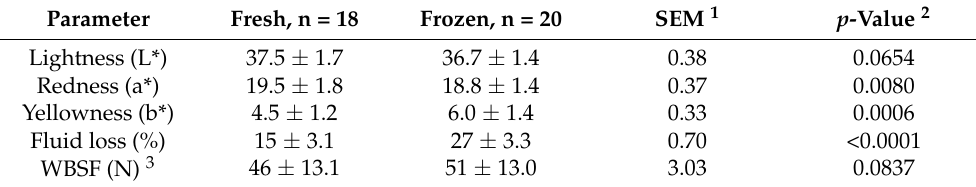
Table 1. Colour parameter values, cooking loss and shear force values (WBSF) of lamb meat tested fresh and after frozen storage for three months (mean ± standard deviation). Parameter Fresh, n = 18 Frozen, n = 20 SEM 1 p -Value 2 Lightness (L*) 37.5 ± 1.7 36.7 ± 1.4 0.38 0.0654 Redness (a*) 19.5 ± 1.8 18.8 ± 1.4 0.37 0.0080 Yellowness (b*) 4.5 ± 1.2 6.0 ± 1.4 0.33 0.0006 Fluid loss (%) 15 ± 3.1 27 ± 3.3 0.70 <0.0001 WBSF (N) 3 46 ± 13.1 51 ± 13.0 3.03